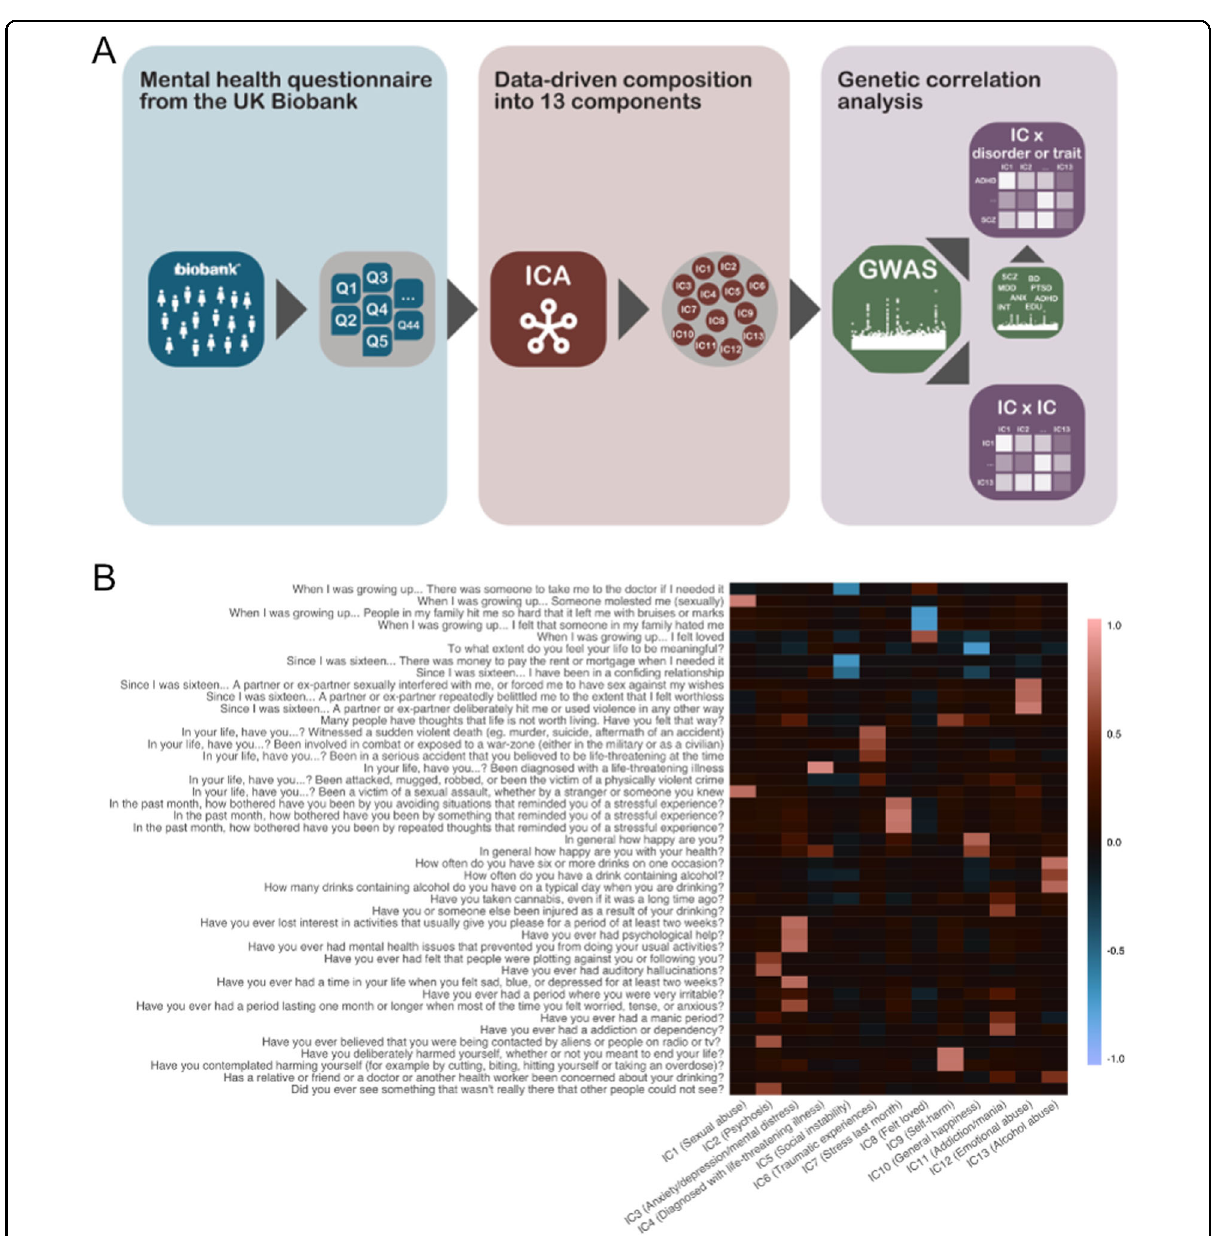
Fig. 1 Work fl ow and variable weight matrix of the resulting decomposition. A Outline of the analysis work fl ow. B Weight matrix re fl ecting how each mental health question loaded on each IC. Brighter colors indicate higher loading and darker colors indicate lower loading. All 43 questions were captured by at least 1 of the 13 independent components. To facilitate interpretation, loadings of IC1, IC2, IC5, IC9, IC10, IC11, and IC12 were inverted so that all components showed the same direction of effect (higher component score indicating increased scoring on the